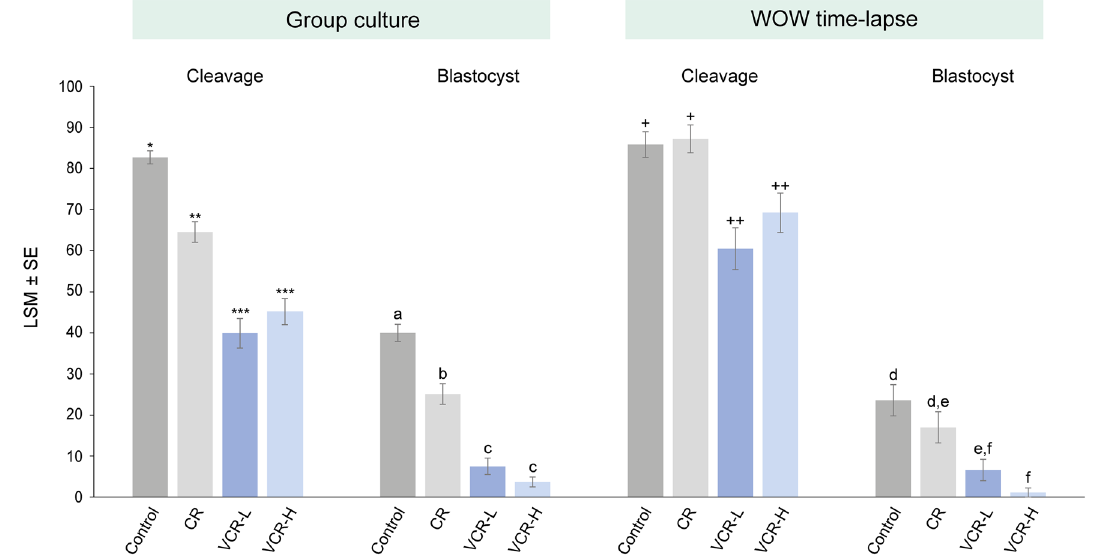
Figure 2. Cleavage and day 8 blastocyst rate over zygotes starting in vitro culture after 21 h of in vitro fertilization. Different superscripts (*, **; a, b;+, ++; d, e) per group of bars represent statistical differences ( p < 0.05). Results are stated as least square means ± standard errors. Control: fresh cumulus enclosed oocytes. Corona radiata (CR): fresh partially denuded oocytes enclosed by the CR only. VCR-H: CR oocytes vitrified with a protocol using high concentrations of cryoprotectants (15%) in equilibration solution. VCR-L : CR oocytes vitrified with a protocol using a low cryoprotectant (3%) concentration in equilibration solution. Numbers of zygotes in group culture (Control: n = 582, CR = 369, VCR-L = 183, VCR-H = 239) and in Well-of the-well (WOW) time-lapse (Control = 127, CR = 94, VCR-L = 91, VCR-H =